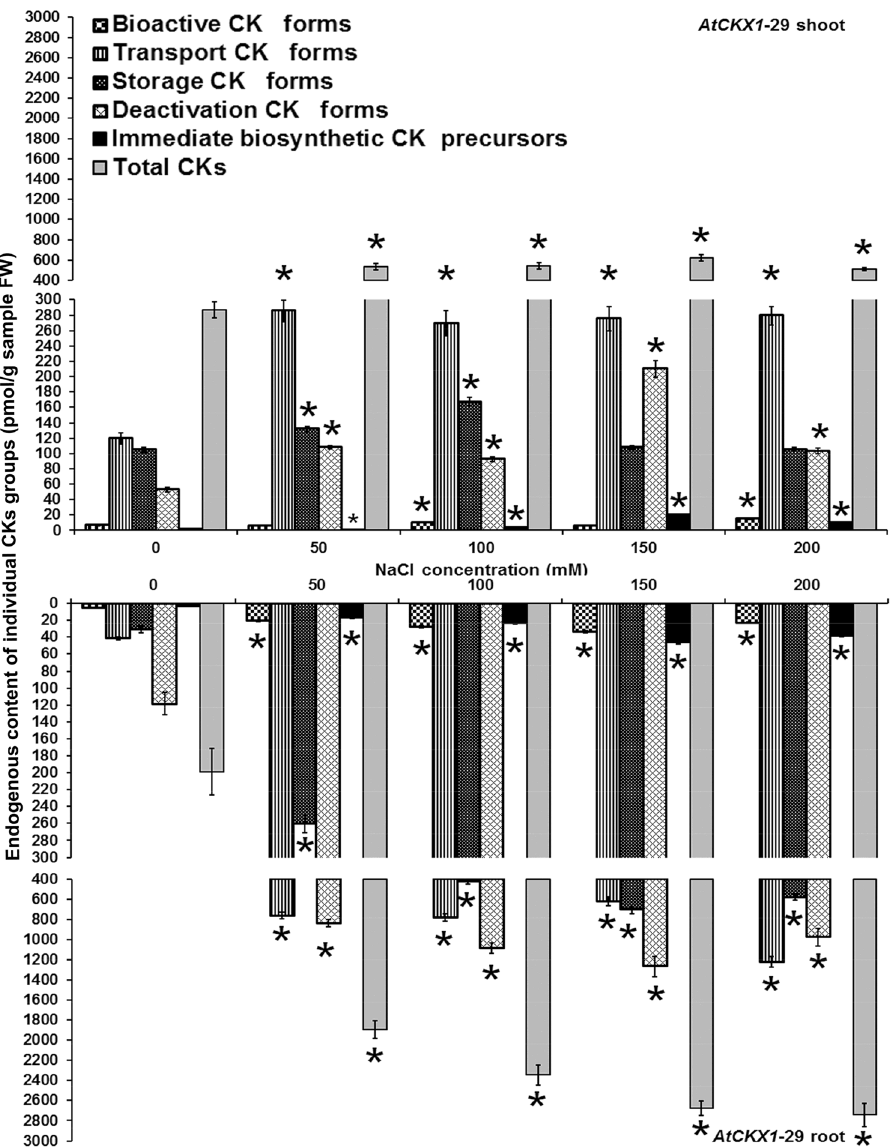
Figure 2. Endogenous cytokinin content in shoots and roots of 8-week-old AtCKX1 -29 transgenic Centaurium erythraea line. According to physiological function and conjugation status cytokinins were divided into five groups including bioactive forms (DHZ, iP, tZ , c Z), transport forms (DHZ9R, iP9R, t Z9R, c Z9R), storage forms (DHZ9ROG, DHZOG, t Z9ROG, t ZOG, c Z9ROG, c ZOG), deactivation forms (DHZ7G, DHZ9G, iP7G, iP9G, t Z7G, t Z9G, c Z7G, c Z9G), immediate biosynthetic precursors ( t ZRMP, DHZRMP, c ZRMP, iPRMP) and total CKs content (boja kolone). Data represent mean ± standard error. Means marked with asterisks are significantly different from corresponding control values (LSD test, p ≤ 0.05). The bigger asterisks represent the values significantly higher than control ones while smaller asterisks represent values significantly lower than control